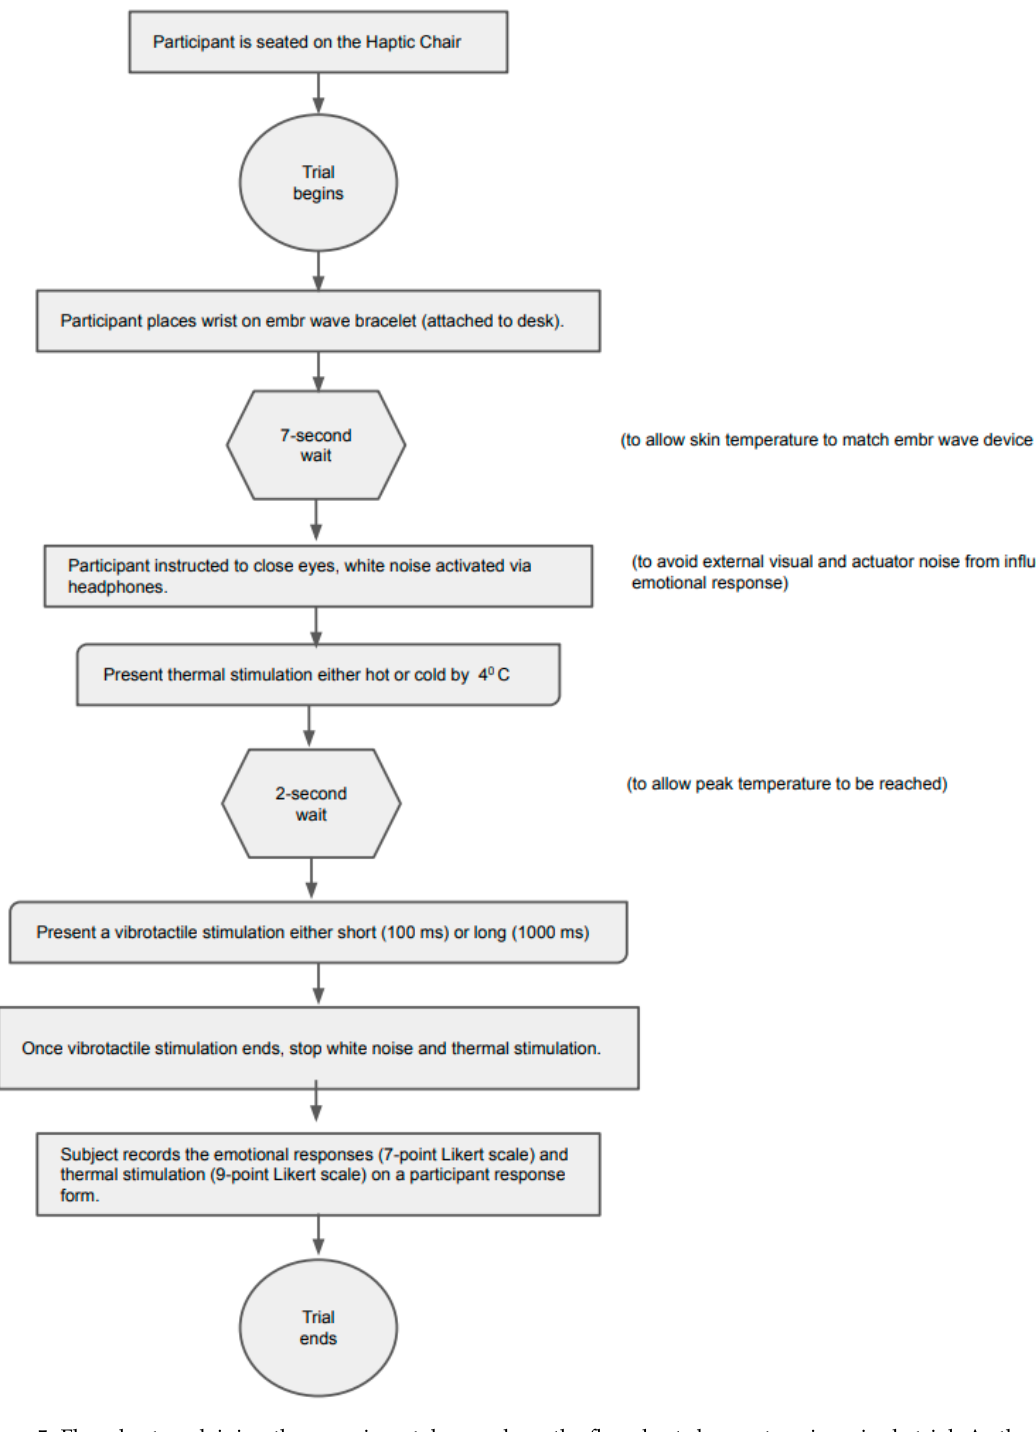
Figure 5. Flowchart explaining the experimental procedure; the flowchart shows steps in a single trial. As there were a total of 12 vibrotactile spatiotemporal patterns and 2 dynamic thermal changes (hot and cold), a total of 48 trials were conducted per participant.